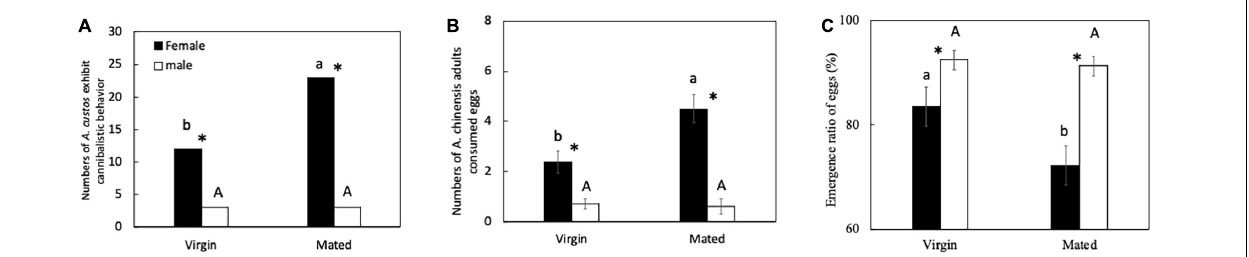
FIGURE 1 | (A–C) Predatory behavior by A. custos on different-aged eggs. Different lowercase letters indicate significant differences among females at p < 0.05 and different uppercase letters indicate significant differences among males at p < 0.05. The investigation was repeated 30 times. * indicates a significant difference between the black bar and white bar at p < 0.05 (female and male virgins or female and male mated individuals).